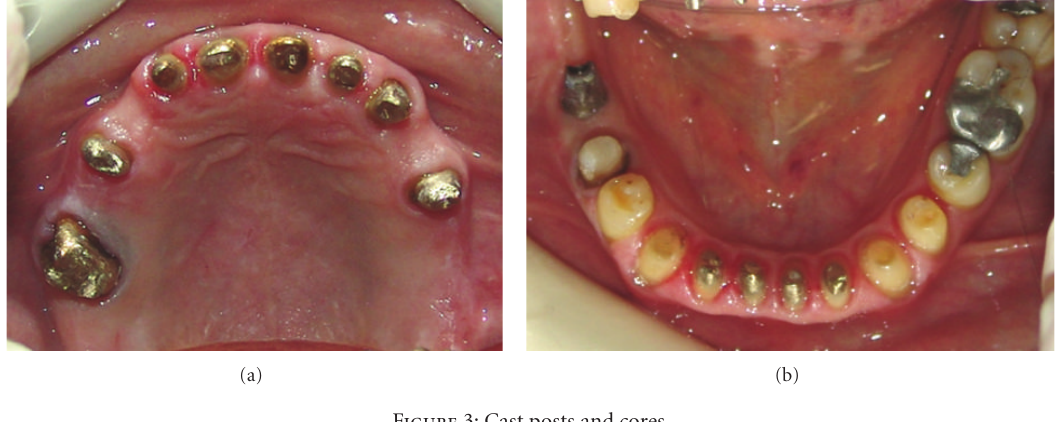
Figure 3: Cast posts and cores.